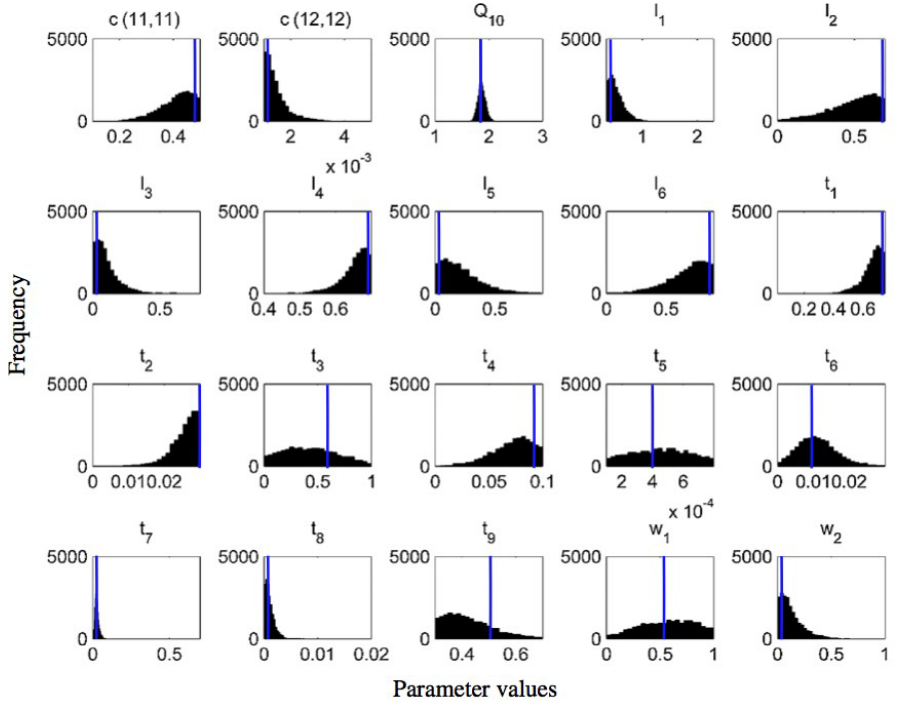
Figure 8. Frequency distributions of 20 calibrated parameters of the CLM-CASA’ model using the Bayesian MCMC approach (Harauk et al., 2014) and surrogate-based optimization (blue line in each graph).